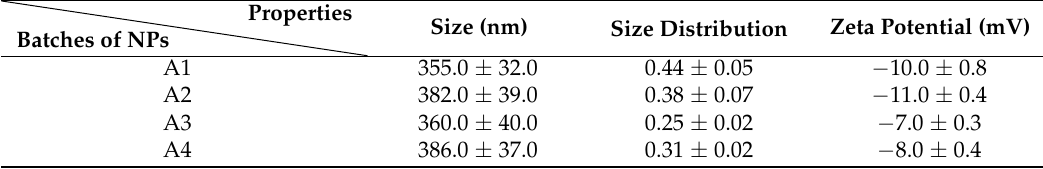
Table 1. The size, size distribution, and zeta potential of various batches of cisplatin-loaded polybutylcyanoacrylate (PBCA) nanoparticles (NPs). A1 (0.25% w / v PEG concentration,